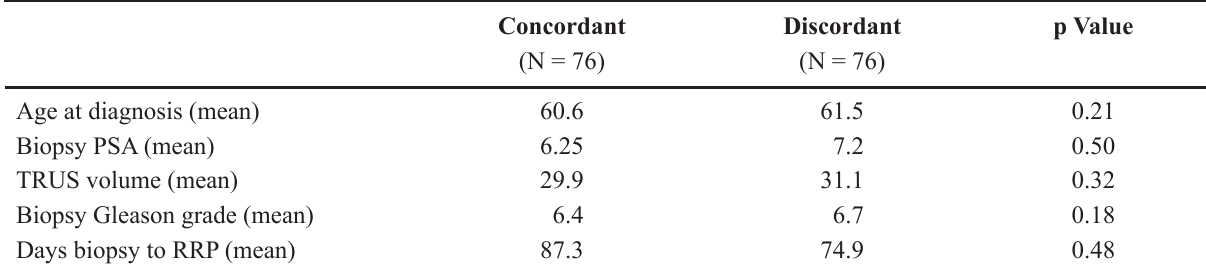
TRUS = transrectal ultrasound; RRP= radical retropubic prostatectomy.